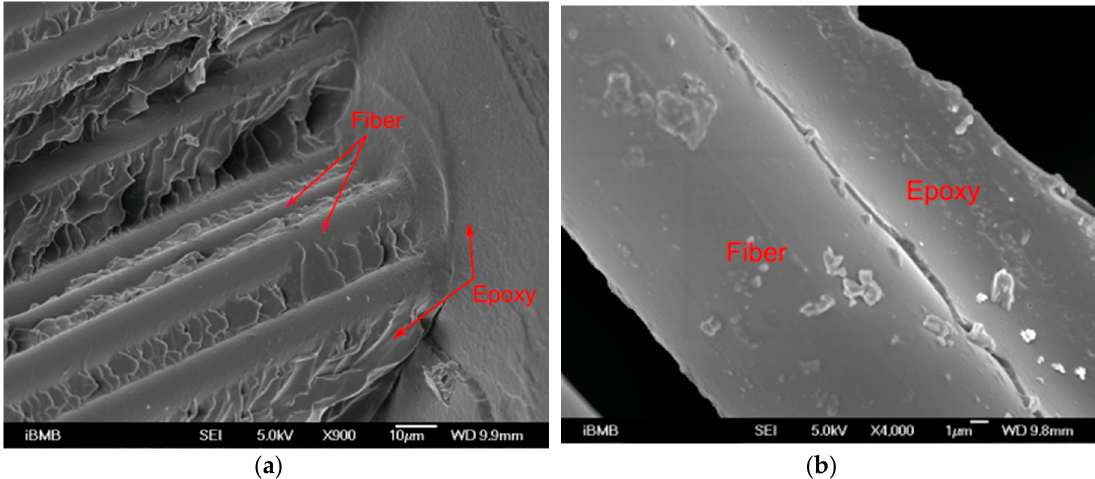
Figure 7. The fracture surface from SEM of ( a ) the interface between epoxy and basalt fiber, ( b ) a close-up of the interface.